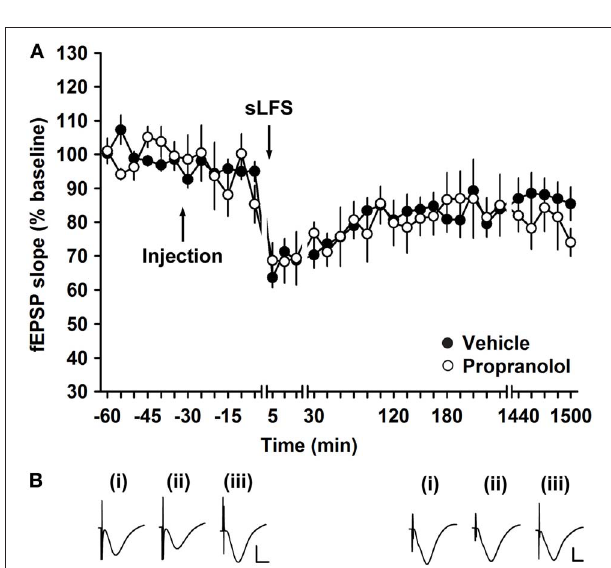
FIGURE 4 | Electrically induced short-term depression of mossy fiber synapses is not altered by a β -adrenergic receptor antagonist. (A) In control groups, stimulation with 600 pulses at 1Hz (sLFS), elicits STD at mf-CA3 synapses. Injection of the β -adrenergic receptor antagonist, propranolol (2 μ g), has no influence on the evoked fEPSPs compared to vehicle-injected animals in the control group. Line breaks indicate changes in time scale. (B) Traces show analogs that represent fEPSP responses obtained pre-sLFS (i), 5min post-sLFS and 24h after sLFS in the presence of vehicle ( left panel ) or propranolol ( right panel ). Vertical scale bar: 2mV, horizontal scale bar: 6ms.